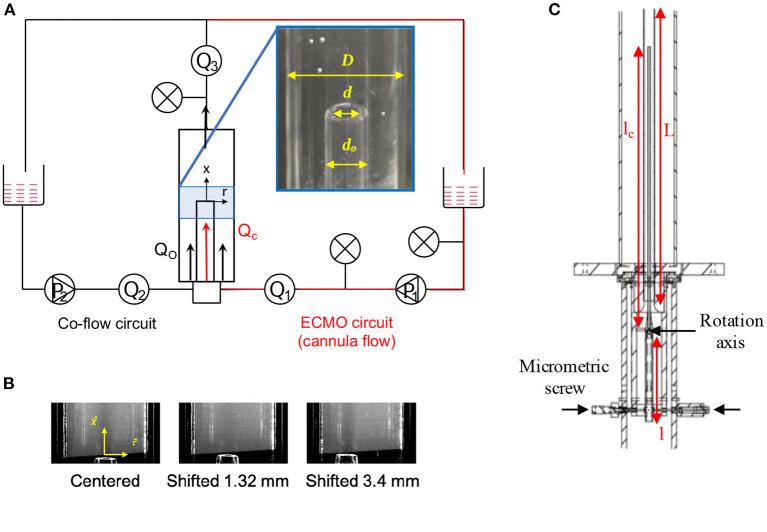
(A) Scheme of the experimental rig with the instrumentation including a picture of the cannula inside the outer tube with corresponding dimensions. The co-flow flow circuit is the equivalent of the native venous flow circuit. (B) Pictures of cannula alignment for the three different positions studied. (C) Drawing of the tube system showing the dimensions of the inlet elements and the inclination system: length tube before constriction l = 400 mm, cannula length lc = 500 mm, and outer tube length L = 1 m.